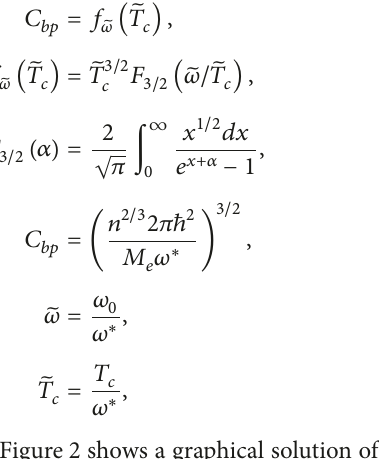
̃𝑇 = 27,3 ; ̃𝑇 𝑐 𝑖 : 𝑐 1 = 50 𝑐 6